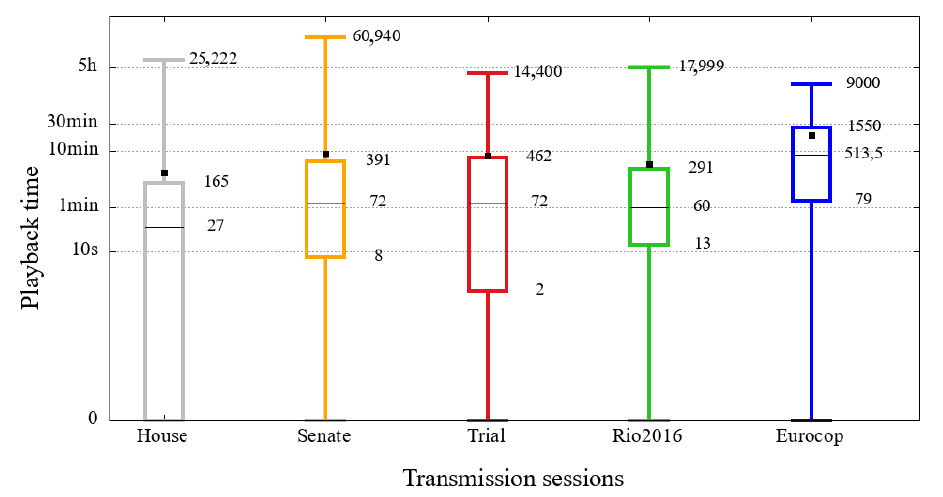
Figure 18. Distribution of user playback time in the opening session of the Rio 2016 Olympics, the 2016 Eurocup semi-final between Portugal and Wales and the House of representatives, Senate and Judgment Impeachment sessions.